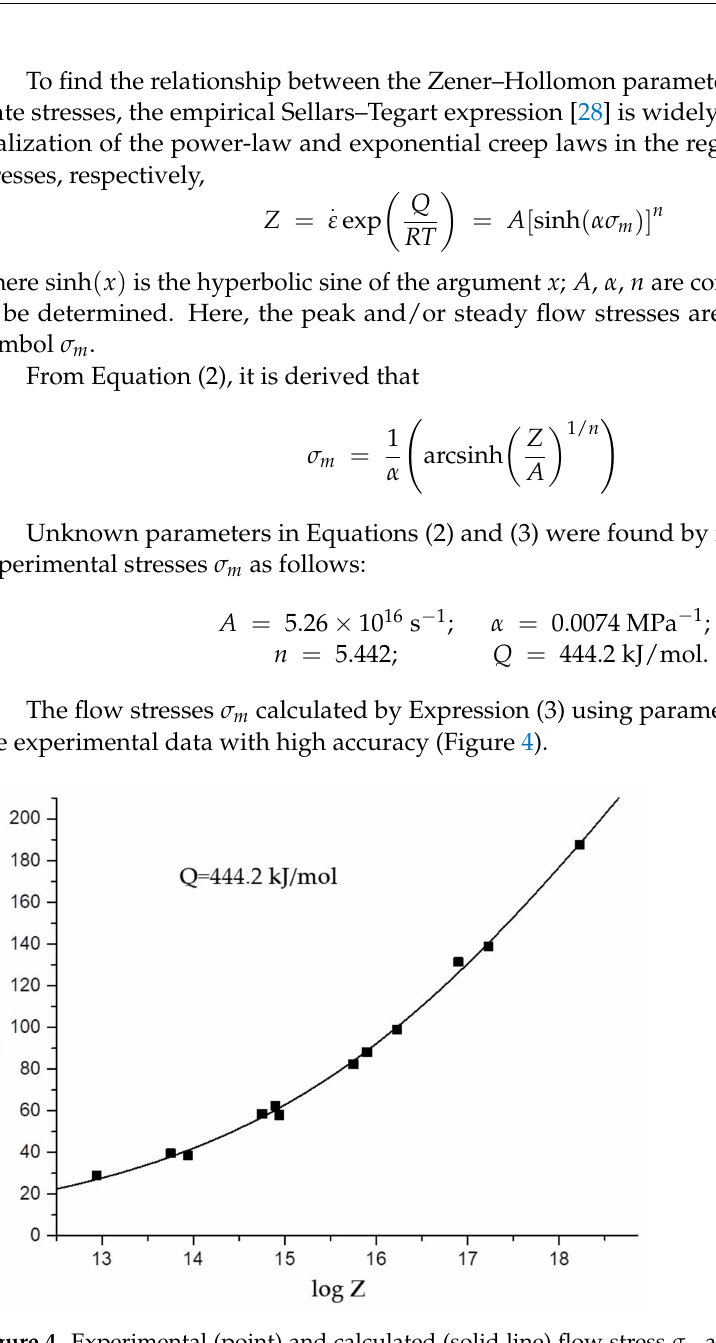
Figure 4. Experimental (point) and calculated (solid line) flow stress σ m as function of the Zener– Holloman